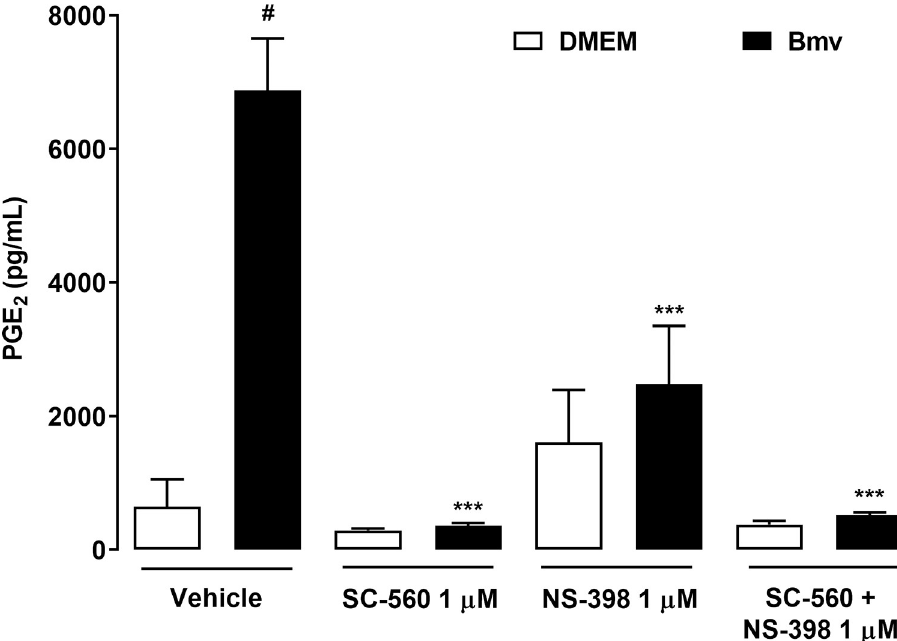
Fig 3. COX-1 and COX-2 participate in Bmv-induced PGE 2 release by preadipocytes. 3T3-L1 preadipocytes were pretreated with COX-1 and COX-2 selective inhibitors SC-560 and NS-398, respectively, or vehicle (DMSO < 1%) for 1 h and then stimulated with Bmv (1 μ g/mL) or DMEM (control) for 24 h. Concentration of PGE 2 present in supernatants was quantified by EIA. Results are expressed as mean + SEM (n = 4). # p < 0.05 vs. negative control (vehicle + DMEM); ��� p < 0.001 vs. positive control (vehicle + Bmv) (ANOVA and Bonferroni post test).